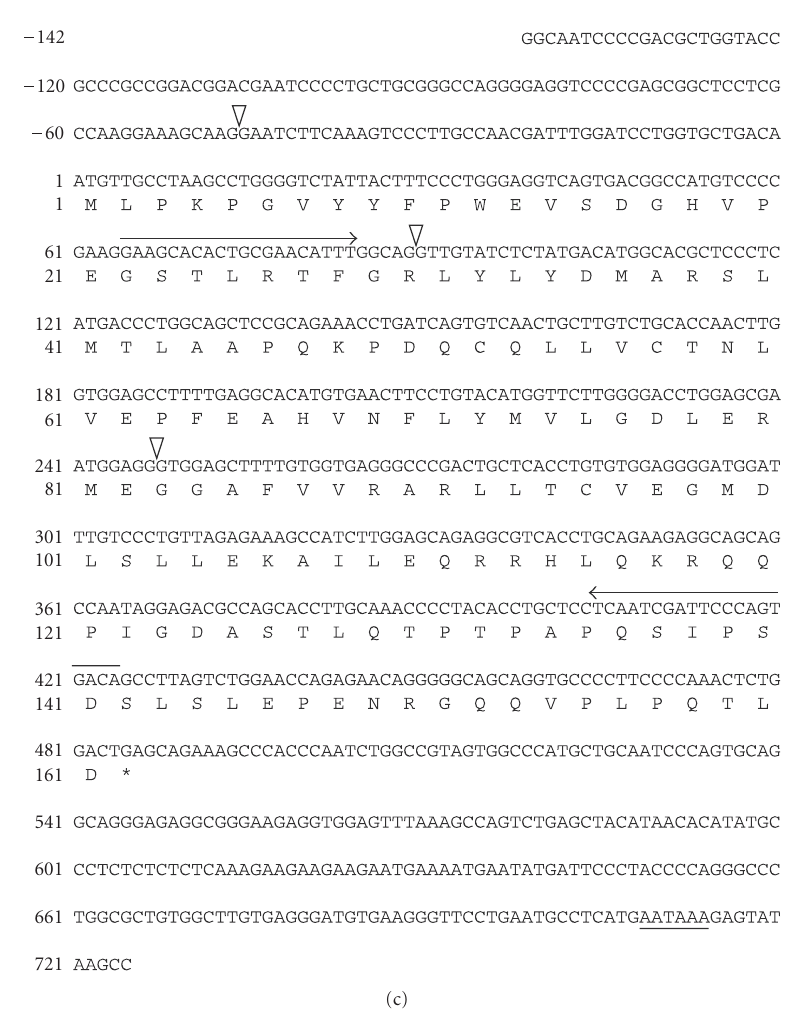
Figure 1: Identification of GSPA in the mouse genome. (a) GSPA is positioned closely adjacent to the AOX gene in the opposite orientation. Exons are shown with boxes and numbered. For AOX gene, only exon 1 is presented, starting from the minor transcriptional initiation site. Open, filled, and gray areas indicate noncoding, GSPA-coding, and AOX-coding regions, respectively. Closed circles denote two PPRE-like motifs. In the enlarged view, exon 1 of each gene is depicted together with the transcriptional orientation shown with horizontal arrow. (b) Alignment of mouse and rat genomic sequences around the transcriptional initiation sites of GSPA and AOX genes including the two PPRE-like motifs. Nucleotide numbers are shown starting from the transcriptional initiation site of GSPA, with increasing numbers in the direction of GSPA transcription. Exon 1 of GSPA, mouse AOX, and rat AOX are boxed with solid, broken, and chain lines, respectively. Major and minor transcriptional initiation sites of the genes are indicated with large and small arrows, respectively, pointing the direction of transcription. Closed circles, asterisks, and dashes denote two PPRE-like motifs, nucleotides conserved between mouse and rat, and gaps, respectively. Horizontal arrows indicate sites of PCR primers 1F and 1R, used for reporter construction. (c) cDNA and predicted amino acid sequences of mouse GSPA. Nucleotides and amino acids are numbered taking the first letter of the predicted initiation codon and initiator methionine as 1, respectively. Nucleotides of the 5 (cid:2) noncoding region are indicated with negative numbers. Amino acids are presented with single-letter codes, asterisk indicating a stop codon. Triangle denotes the position of intron insertion. Horizontal arrows and underline indicate the sites of primers for RT-PCR and polyadenylylation signal,